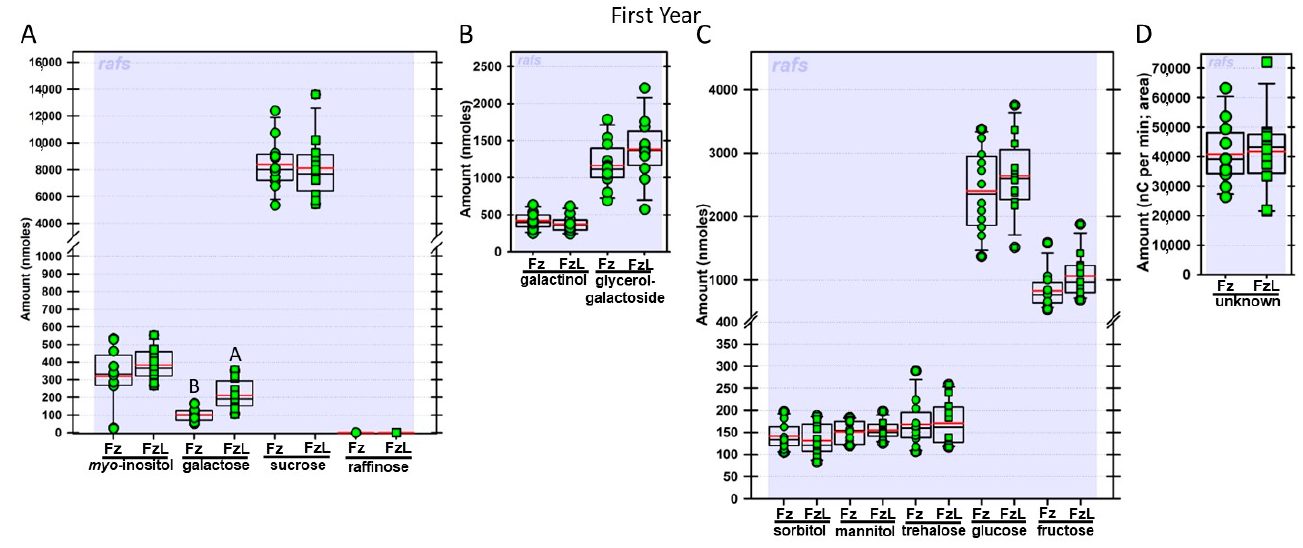
Figure 5. Amounts of soluble carbohydrates from mutant maize leaf disks sampled in year 1. Car- bohydrates were analyzed from raffinose synthase ( rafs ) maize leaves that were frozen after harvest (Fz; light green circles) or were frozen and then lyophilized to dryness (FzL = frozen lyophilized; light green squares). For each carbohydrate, the box and whisker plot depicts the mean (red bar) and median (black bar), with the box capturing the interquartile range (25th to the 75th percentile), the whiskers signify the 10th to the 90th percentile, and outliers are dots beyond these whiskers, if any. For carbohydrate amounts (nmoles) from the same-sized disks, different uppercase letters over the box plots between frozen and lyophilized tissues denote statistically significant differences be- tween treatments (ANOVA, Scheffe’s multiple comparison test, α = 0.05). ( A ): myo -inositol; galac- tose; sucrose and raffinose. ( B ): galactinol and glycerol–galactopyranoside. ( C ): Sorbitol; mannitol; trehalose; glucose, and fructose. ( D ): Area under the curve for unknown 2.